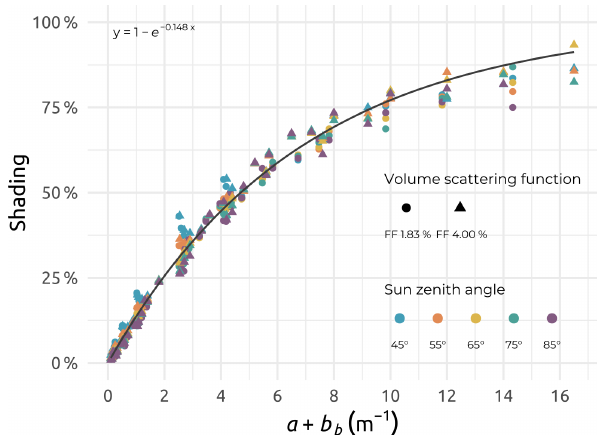
Figure D1. Relationship established between the self-shading com- puted using SimulO and the sum a + b b , with a and b b (in m − 1 ) as the absorption and backscattering coefficients, respectively, for the two particle volume scattering functions (FF 1.83% and FF 4.00%) and five solar zenith angles considered.